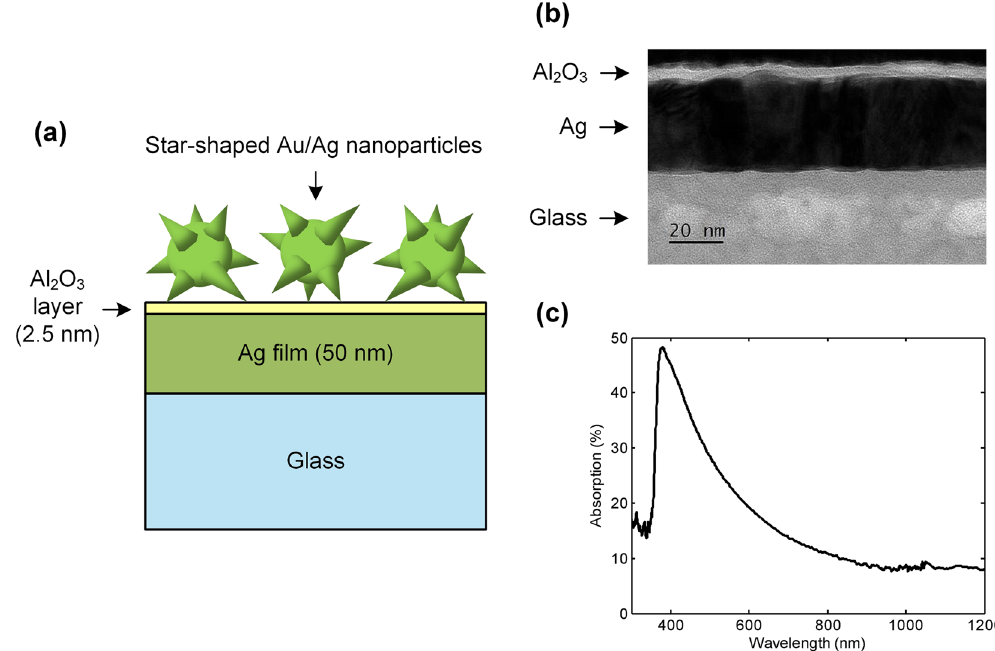
Figure 1. Characteristics of the silver film-based SERS substrate. ( a ) Schematic diagram of the silver film-based substrate (not to scale). Gold, silver, and star-shaped gold/silver nanoparticles are employed in this work. The diagram illustrates the case with star-shaped nanoparticles being employed. ( b ) TEM image of the bulk silver film substrate where nanoparticles are not deposited. ( c ) Absorption spectrum of the bulk silver film